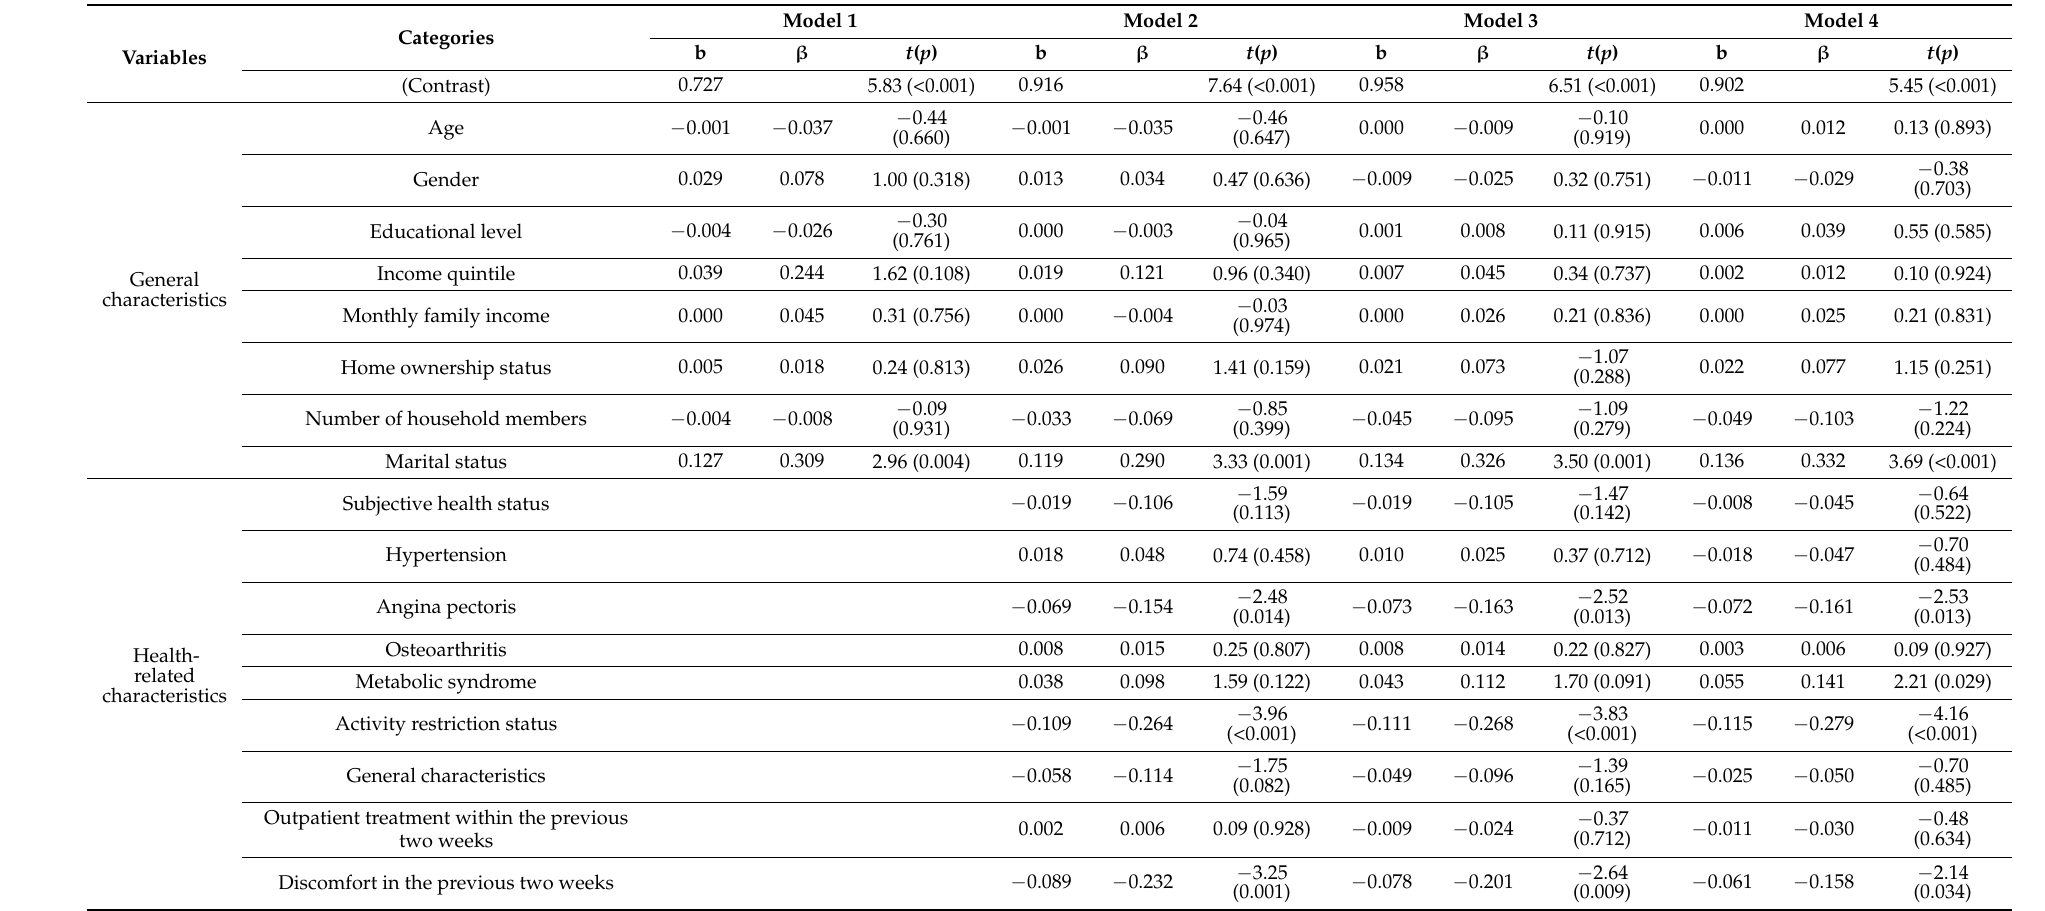
Table 5. Factors influencing health-related quality of life of non-working cancer survivors, n =